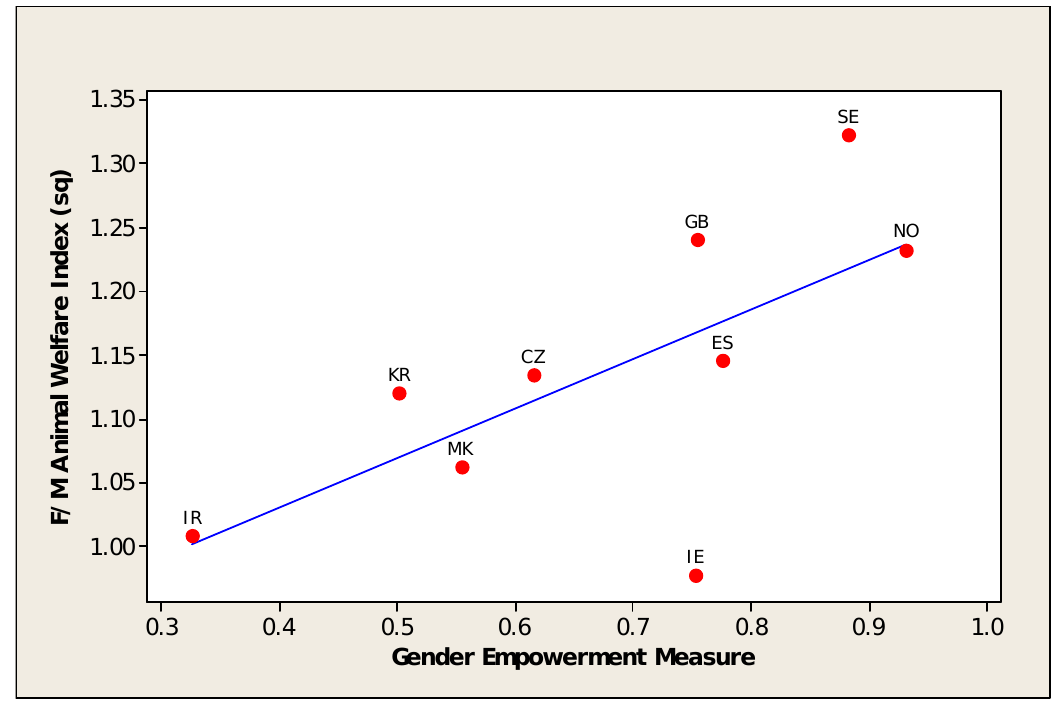
Figure 1. Ratio of female to male (F/M) scores on the Animal Welfare Index 2 to the Gender Empowerment Measure (GEM). CZ = Czech Republic, GB = Great Britain, IR = Iran, IE = Ireland, KR = South Korea, MK = Macedonia, NO = Norway, ES = Spain, SE = Sweden.